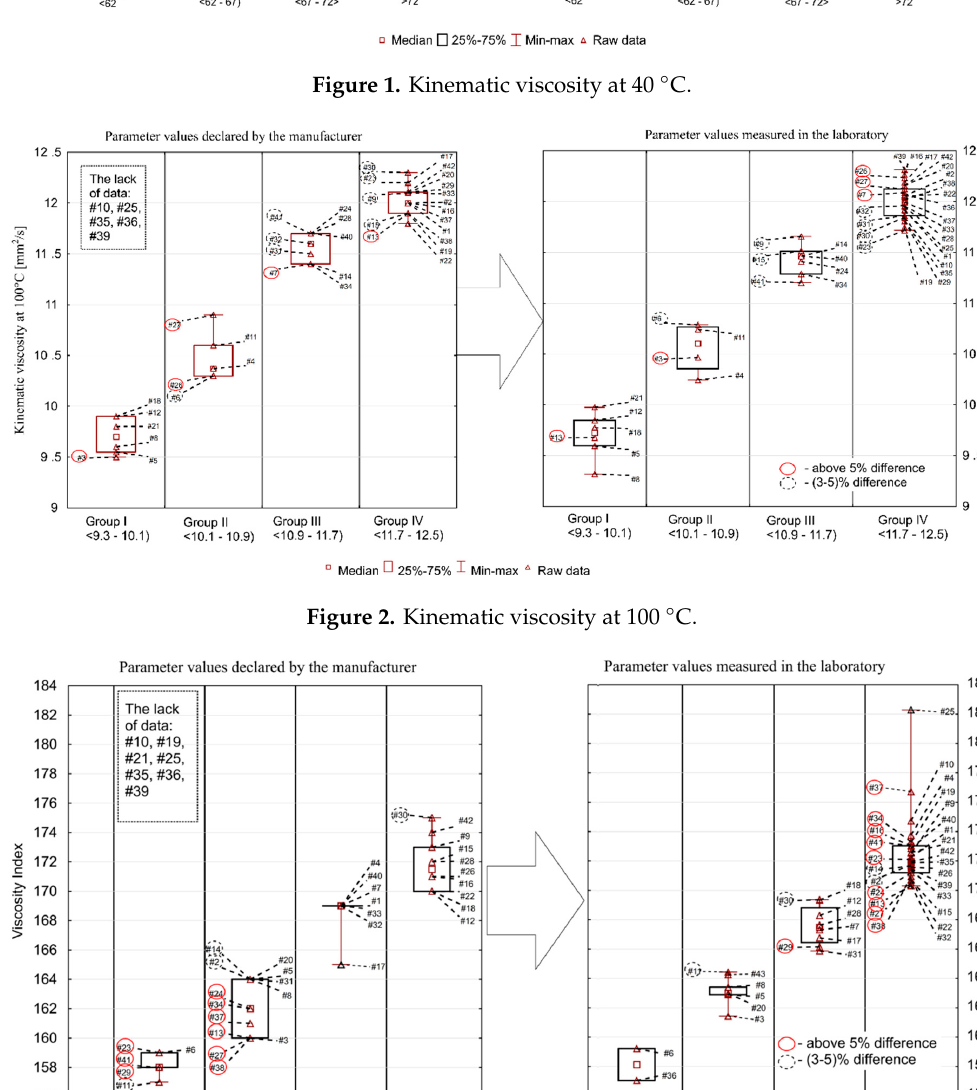
Figure 3. The viscosity index of the engine oil samples tested.